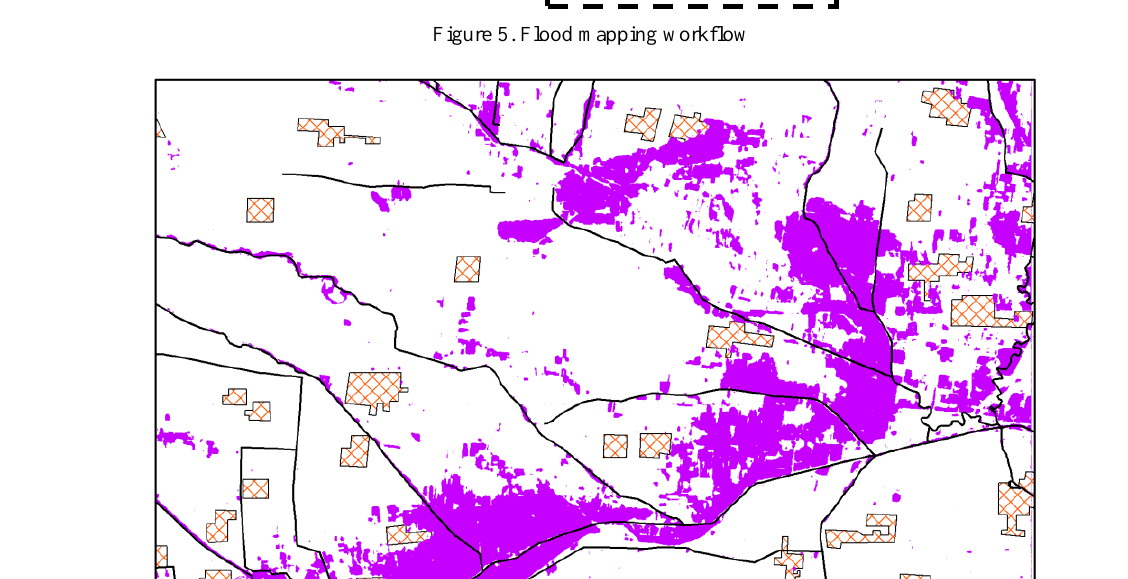
Figure 5. Flood mapping workflow